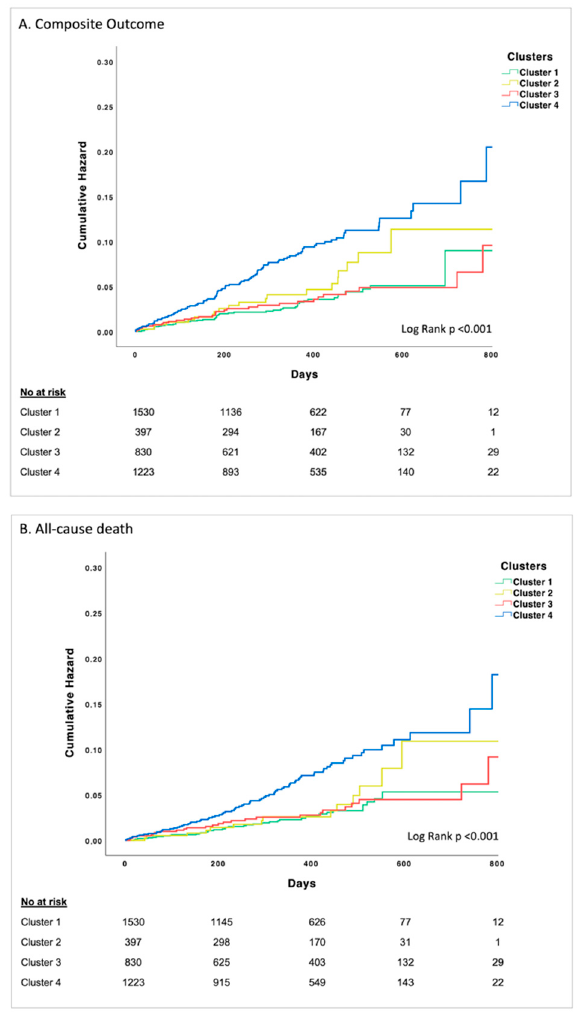
Figure 2. Kaplan-Meier curves for the composite outcome of stroke/thromboembolism, cardiovascular death, myocardial infarction and/or all cause-death ( A ), all-cause death ( B ), and major bleeding ( C ).